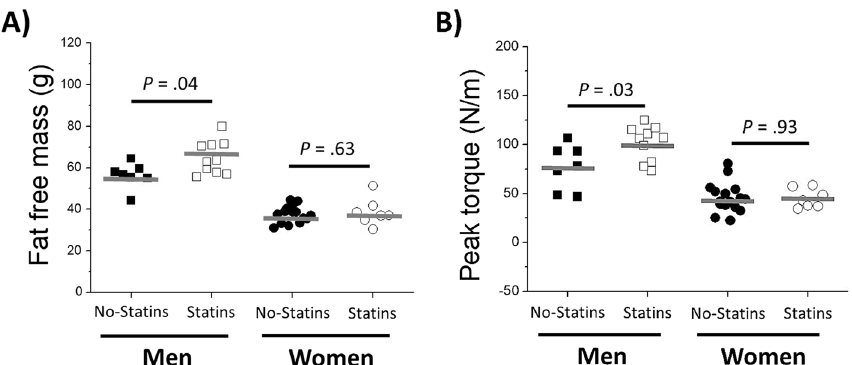
Figure 2. Men but no women living with HIV under statin treatment presented higher fat-free mass and strength comped with PLWH not on statins. ( A ) fat-free mass and ( B ) peak torque at 180°/s among men and women with HIV on and not on statins. Statins protected men, but not women from low fat fee mass and strength. Values are expressed as mean ± standard deviation. p < 0.05, compared with no-statins usage group by test t